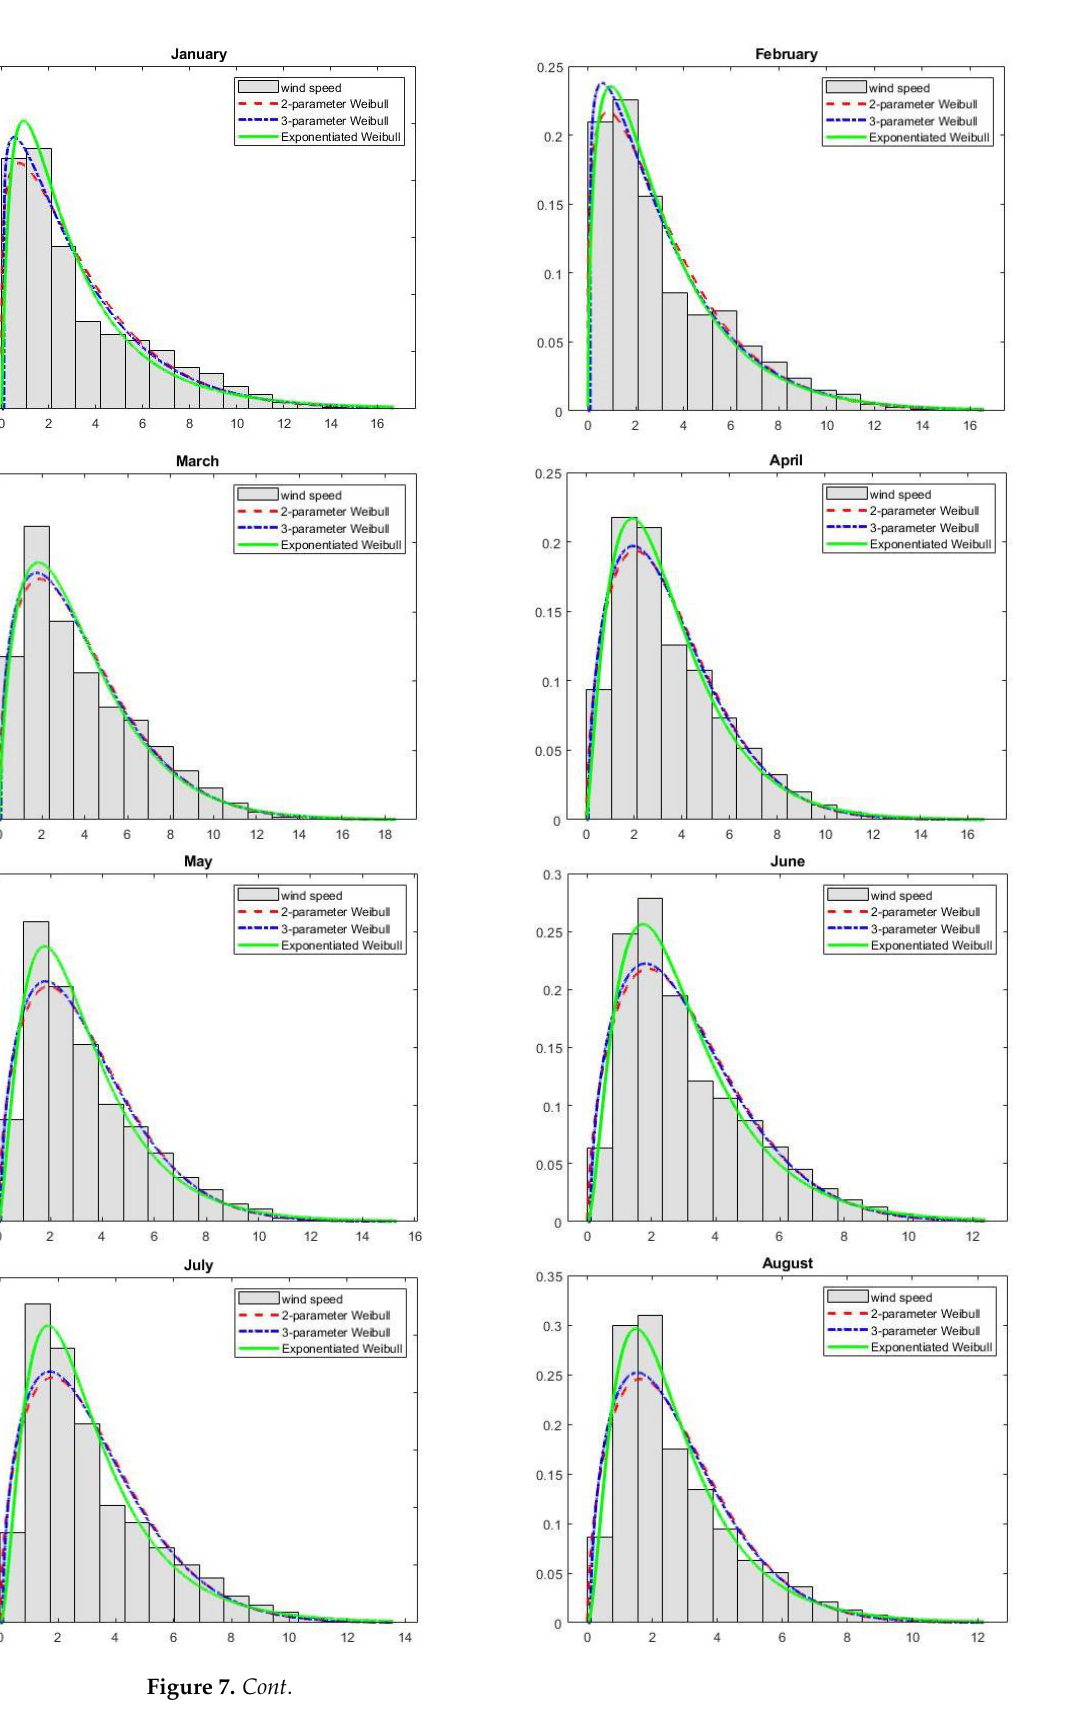
Figure 6. Modelled probability distributions fitted to the histogram of the wind speed data — the seasons.